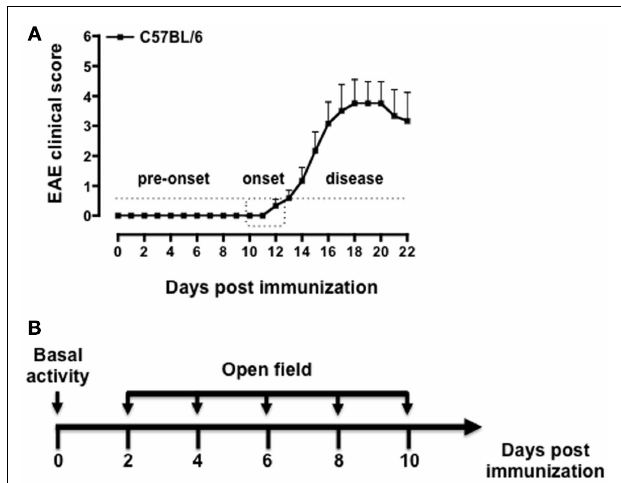
FIGURE 1 | Phases of the disease in MOG 35–55 -induced EAE and behavioral assessment protocol .The graph in (A) shows a typical pattern of development of the EAE clinical score with the three main phases of the disease while the scheme in (B) shows a schematic of the behavioral test protocol used in the study.The results in (A) are from a single experiment with n = 10 mice and are representative of N = 5–6 separate